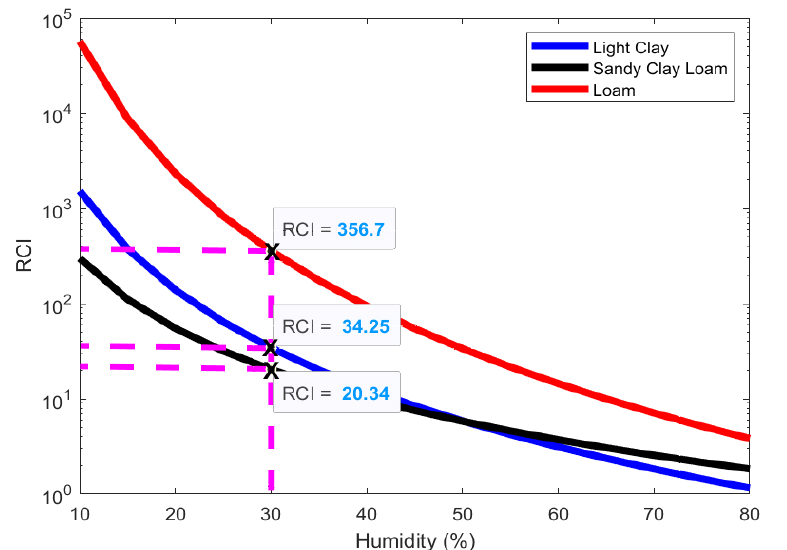
Figure 2. RCI values plotted against different humidity conditions for the three soil types found in the real-life terrain considered in this paper.